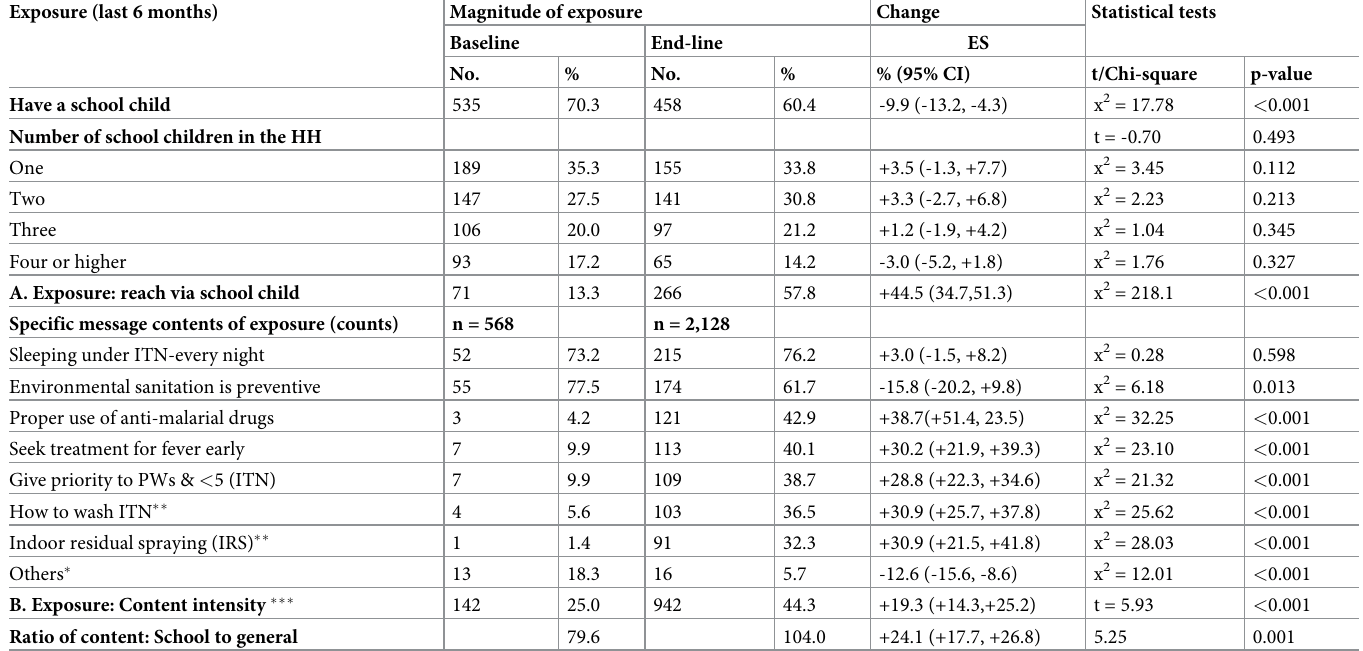
Table 3. Magnitude of changes in community exposure to malaria messages via school-aged children, Jimma Zone, SBCC target districts, 2017–19 (Baseline, n = 762; End-line, n =